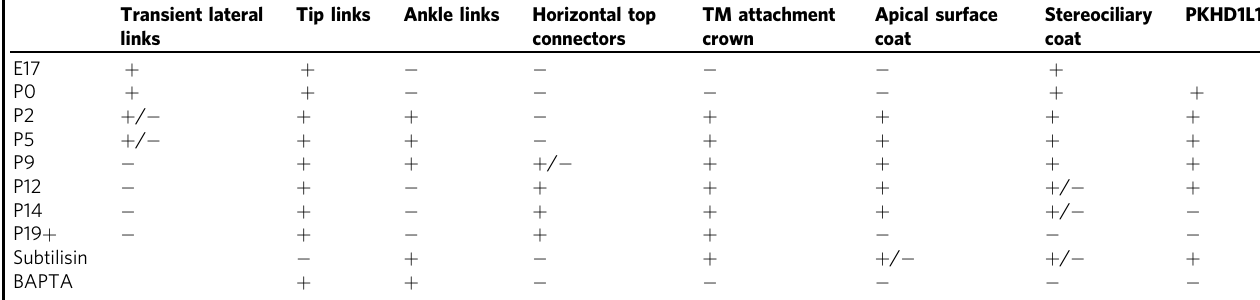
Table 1 Summary of the distribution and reagent sensitivity of the various cell surface specializations Transient lateral links